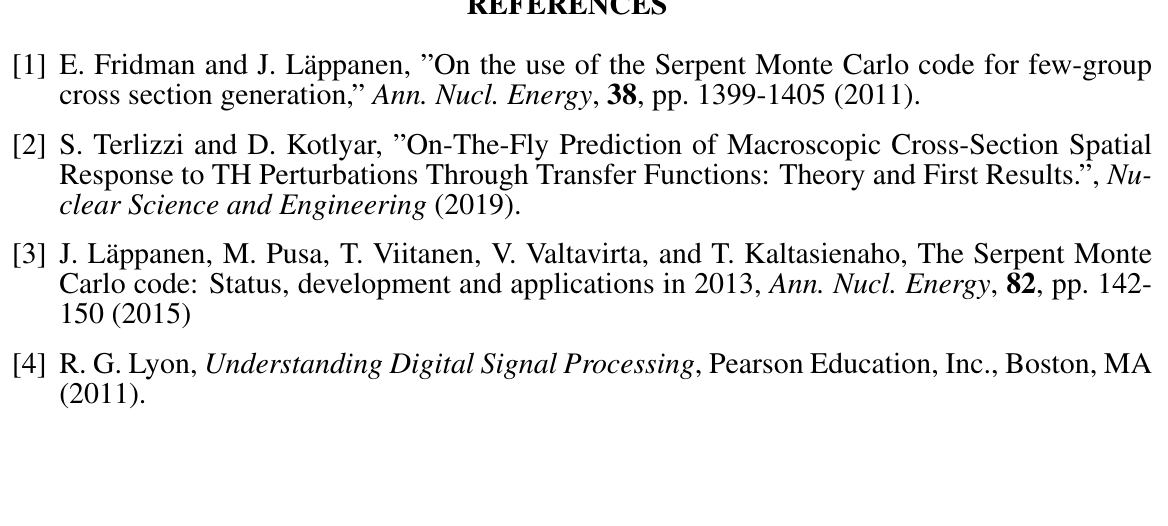
with reduced statistics and (b) Associated 5